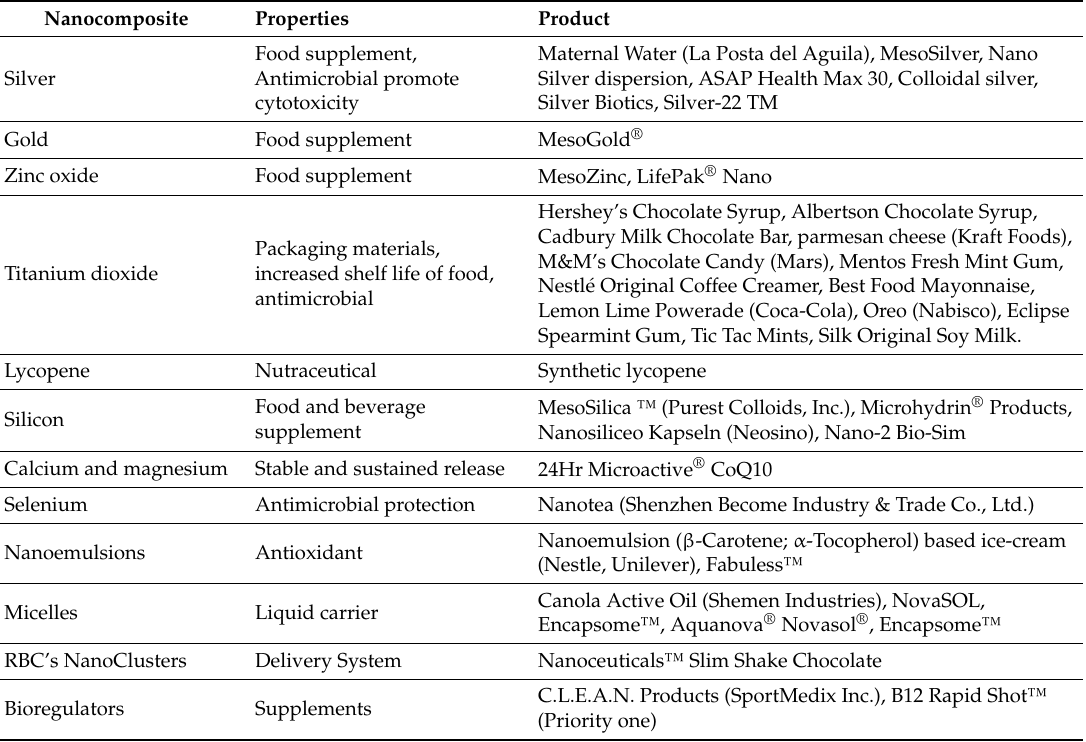
Table 1. Products having nanocomposite materials.